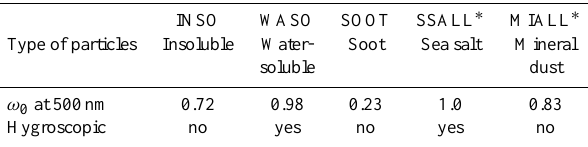
Table 2. GADS-based aerosol components used in SIRAMix. Data are borrowed from Koepke et al.